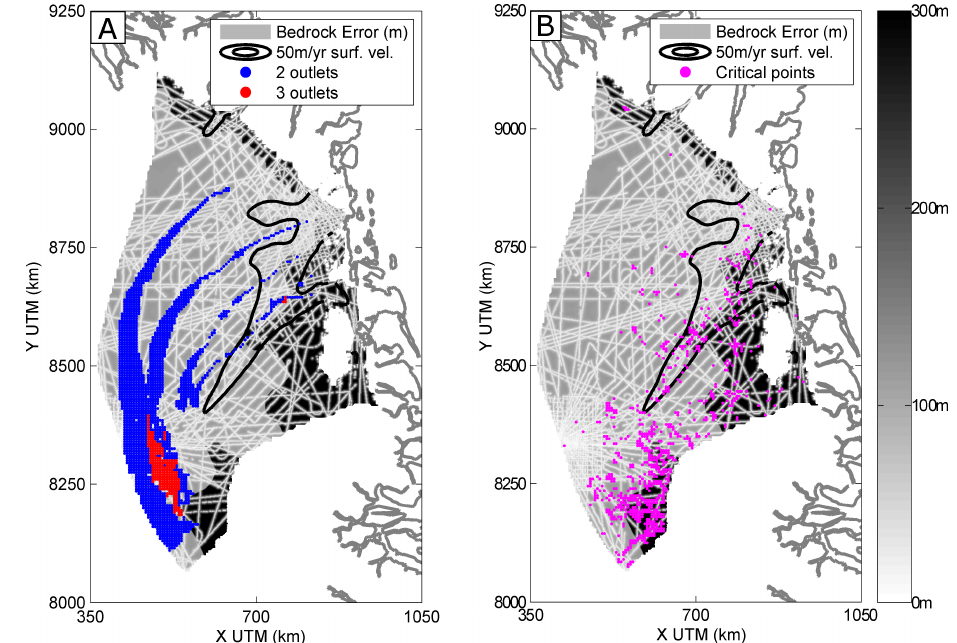
Figure 7. The error associated with the bedrock topography from Bamber et al. (2013a) is in grey. (a) coloured dots indicate grid cells where the subglacial water routeways change between two (blue dots) or three (red dots) outlets. The contour for the 50myr − 1 surface velocity (from Joughin et al., 2010) is indicated with thick, black lines. (b) magenta dots indicate grid cells where the bed slope is equally important to or more important than the surface slope in determining the direction of the subglacial